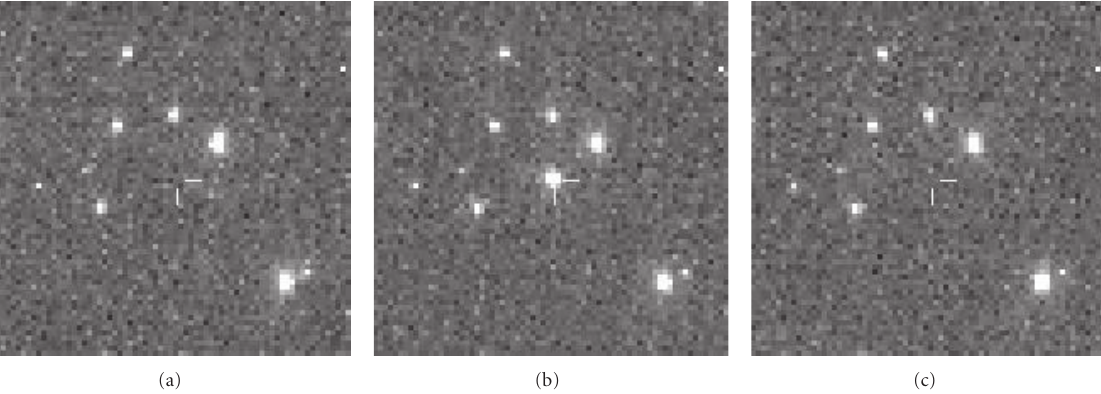
Figure 18: Transient object found simultaneously with GRB081130B at α = 01 h 10 m 20 s δ = +18 ◦ 44 (cid:3) 35 (cid:3)(cid:3) , 14 degrees from the centre of its last GRB081130B localisation. A detailed analysis showed the object to be a short flash produced by the “MOLNIYA” high-orbit satellite.